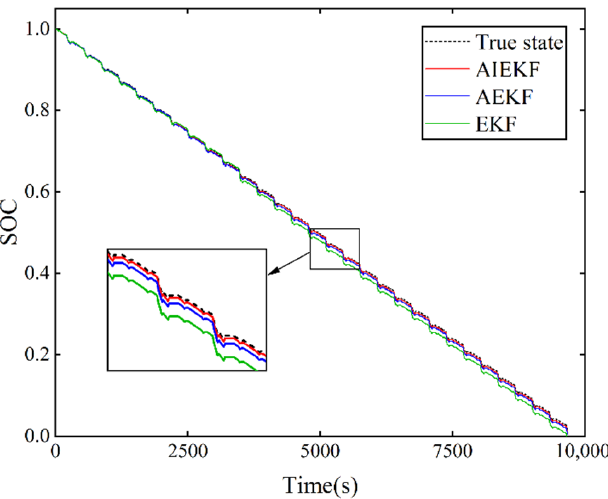
Figure 9. SOC estimation results of AIEKF, AEKF, and EKF under DST operating conditions.